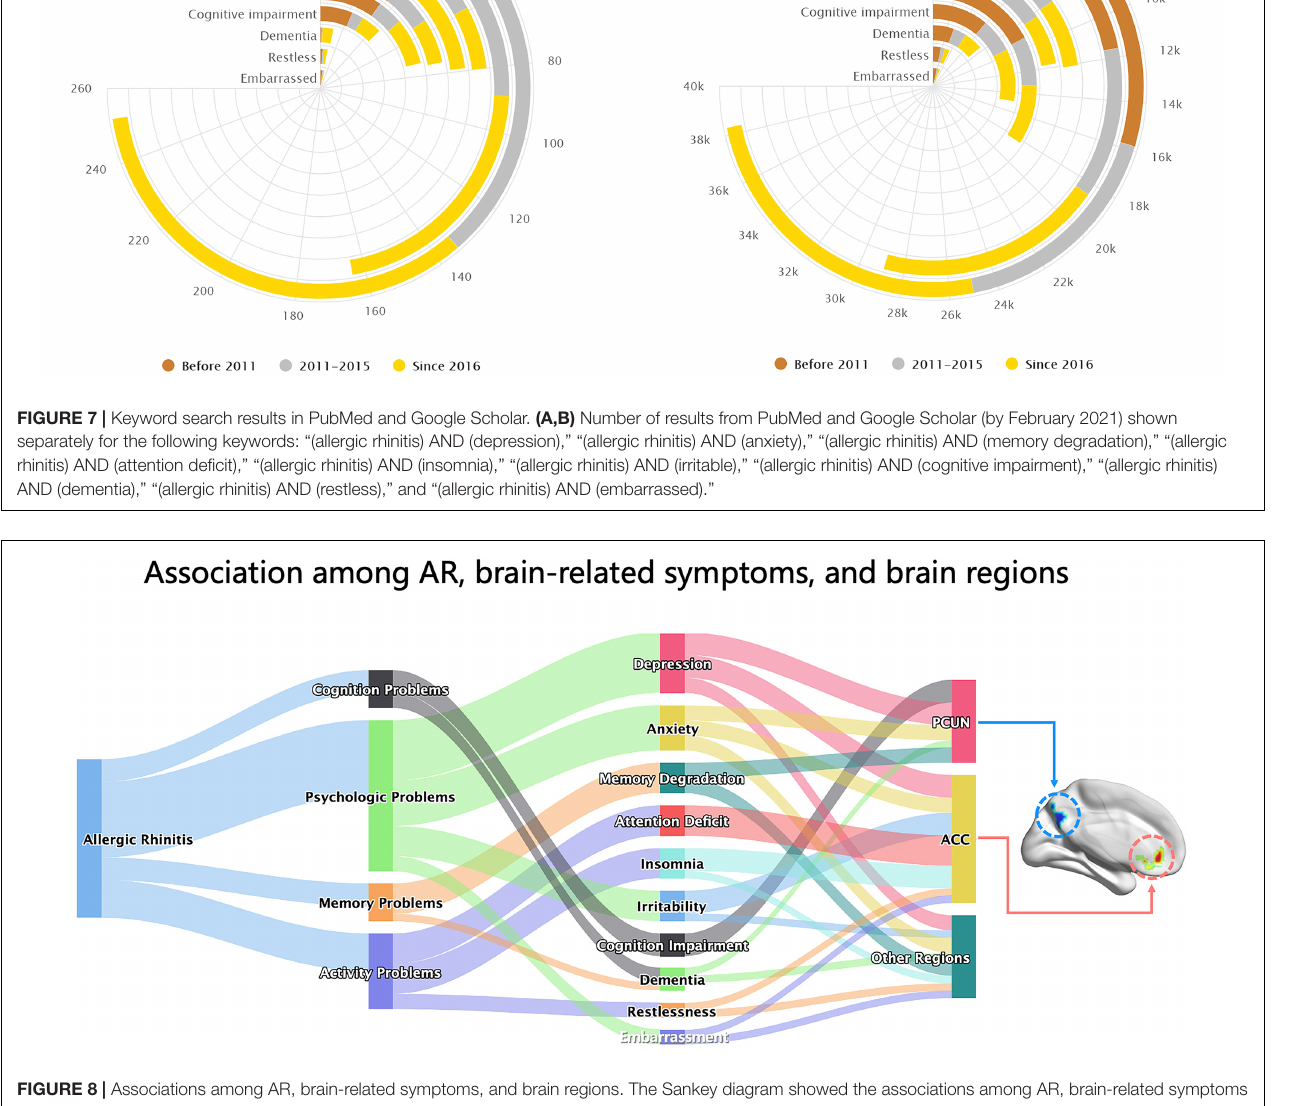
FIGURE 8 | Associations among AR, brain-related symptoms, and brain regions. The Sankey diagram showed the associations among AR, brain-related symptoms (including depression, anxiety, memory degradation, attention deficit, insomnia, irritability, cognitive impairment, dementia, restlessness, and embarrassment, which were grouped into four categories for cognition problems, psychological problems, memory problems, and activity problems), and brain regions (PCUN, ACC, and others) abstractly based on the relationship between them from knowledge of AR literatures. The brain map on the right was our result of the ALFF analysis presented by the BrainNet toolbox in SPM. AR, allergic rhinitis; PCUN, precuneus; ACC, anterior cingulate cortex; ALFF, amplitude of low-frequency